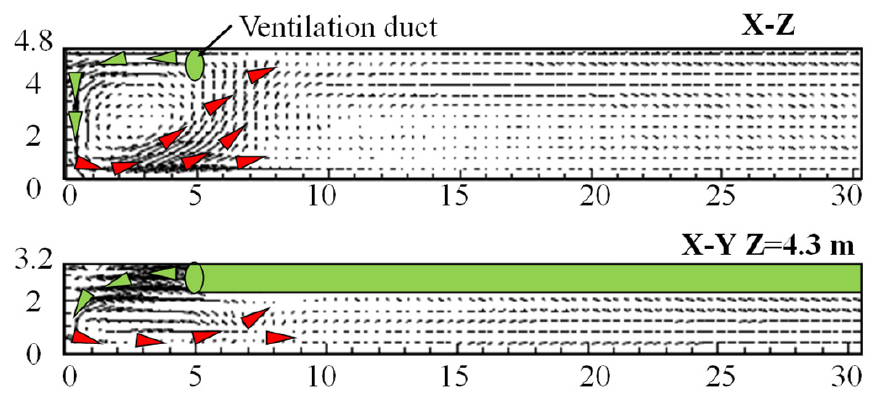
Figure 4. Sketch of the airflow movement directions in tunnel near excavation face. The overall longitudinal flow field of the tunnel from the average over the steady period is shown in Figure 5. The flow field can be divided into three zones based on the airflow velocity and direction: (1) turbulent flow zone, (2) turbulent flow transition zone, and (3) steady flow zone. For the turbulent flow zone, the airflow is chaotic, and a vortex zone is formed between the ventilation duct and excavation face [22], because the airflow is restricted by the excavation face and the side wall [23]. The airflow direction changes after impinging on the wall, and the velocity is high at the bottom of the tunnel (around 5 m to the excavation face). Subsequently, the airflow direction becomes nearly the same, and the airflow velocity decreases with the distance from the excavation face. In the event of a fire in this zone, the vortex can easily lead to backflow, resulting in smoke accumulation near the excavation face. For the turbulent flow transition zone (95% of the airflow direction remains the same), the airflow direction remains relatively stable in the longitudinal direction, and the airflow velocity gradually becomes uniform. The airflow velocity is high near the ceiling and decreases along the vertically downward direction. In the event of a fire in this zone, the airflow near the ceiling would move faster, which could accelerate the smoke spread. For the steady flow zone (95% of the airflow velocity remains the same), both the airflow velocity and directions remain stable. In the event of a fire in this zone, the smoke layer remains steady. The maximum airflow velocity ( V max ) decreases as the air volume decreases. For example, it decreases from 21.065 to 5.476 m/s as the air volume decreases from 1600 to 400 m 3 /min.